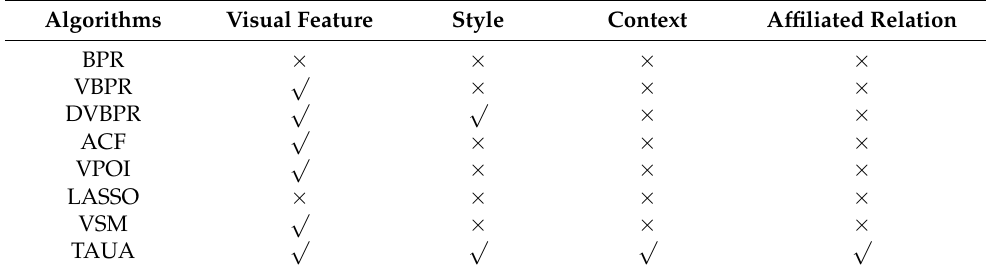
Table 7. Comparison between TAUA with baseline methods. the factor, × means the